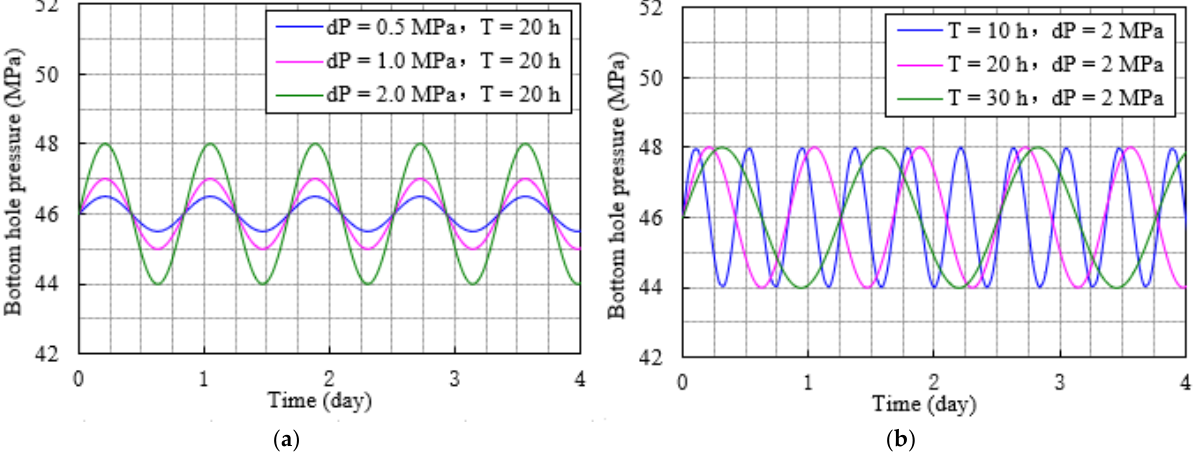
Figure 5. Simulation waveform graph for wellbore bottom pressure variation. ( a ) Constant period of fluctuation; ( b ) Constant amplitude of fluctuation.